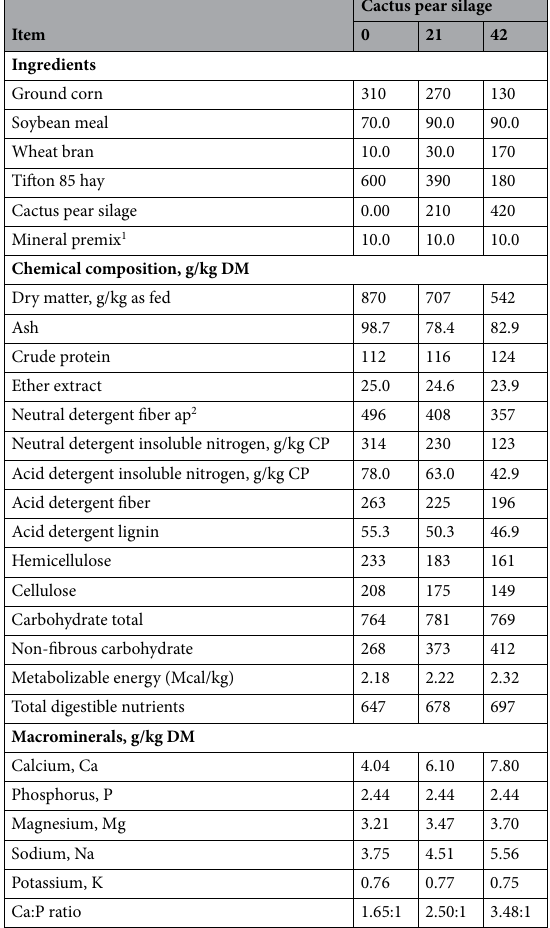
Table 10. Ingredients and chemical compositions of experimental diets (g/kg, DM basis). 1 Mineral